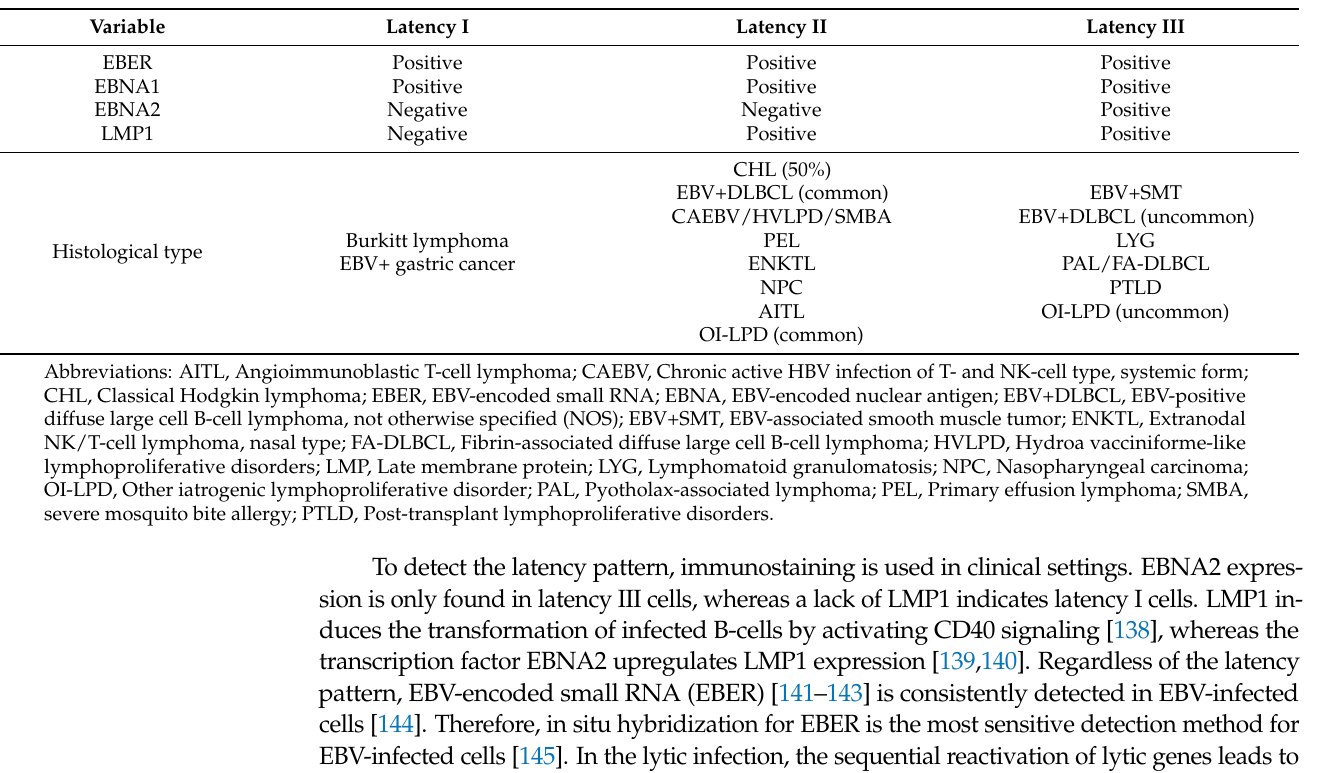
Table 3. The latency patterns of EBV-associated